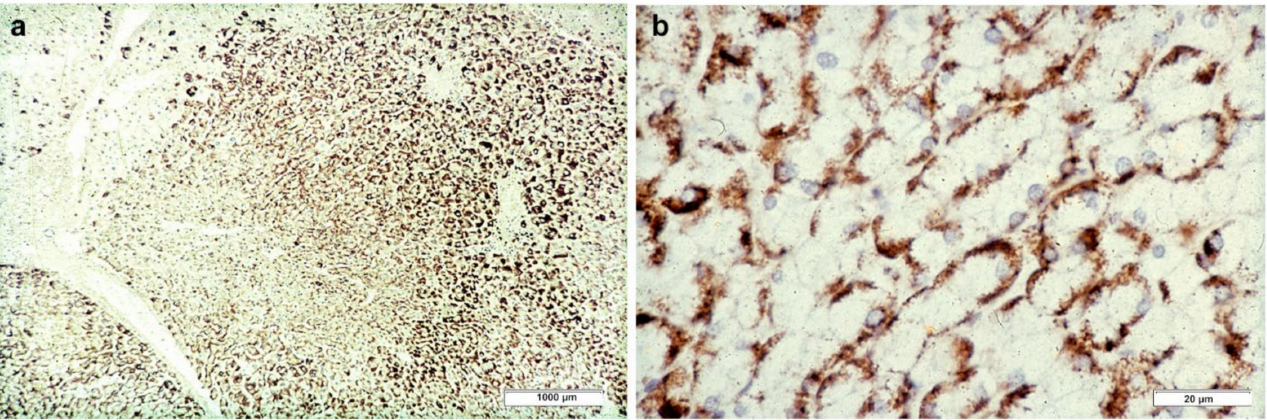
Figure 4. Pi MZ liver specimen. All hepatocytes from adjacent lobules are positively stained for AAT ( a ) polyclonal AAT immunostaining × 2. The intensity of the staining decreases from zone 1, where the positivity involves the whole cytoplasm (type I positivity), to zones 2 and 3 where crescent like and rectilinear double rows pictures are clearly seen. ( b ) polyclonal AAT immunostaining × 100.